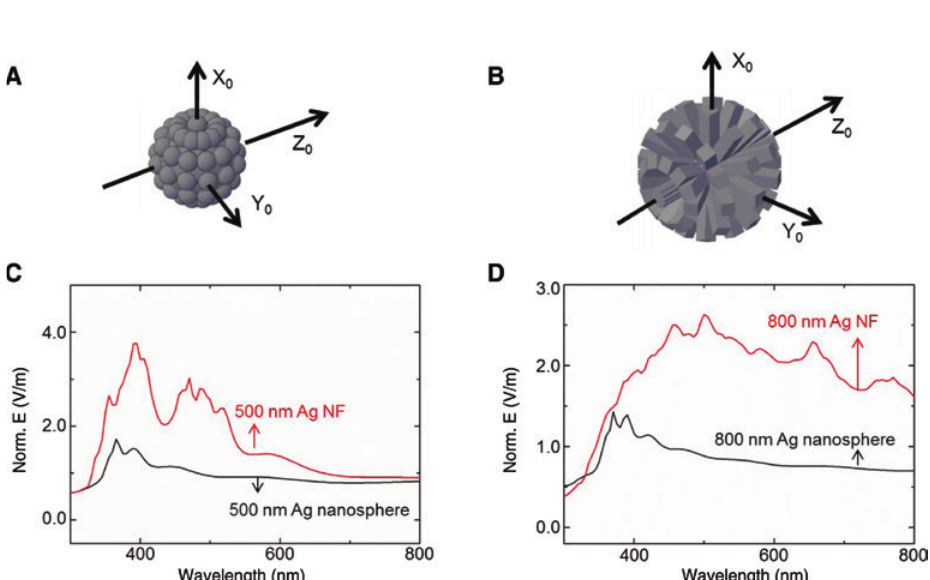
Figure 3: Electromagnetic field enhancement effect of Ag NFs. (A and B) Model of Ag NFs with a diameter of 500 nm (A) and 800 nm (B). (C and D) Normalized average electric distribution of the 500 nm NF and 500 nm nanosphere (C) and 800 nm NF and 800 nm nanosphere